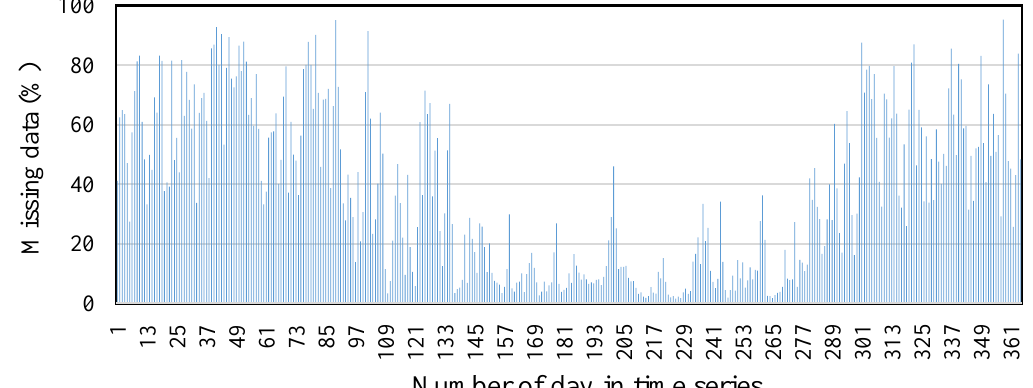
Figure 3. The missing data percentage of each image (temporal dispersion) in the annual LST time series during the day.